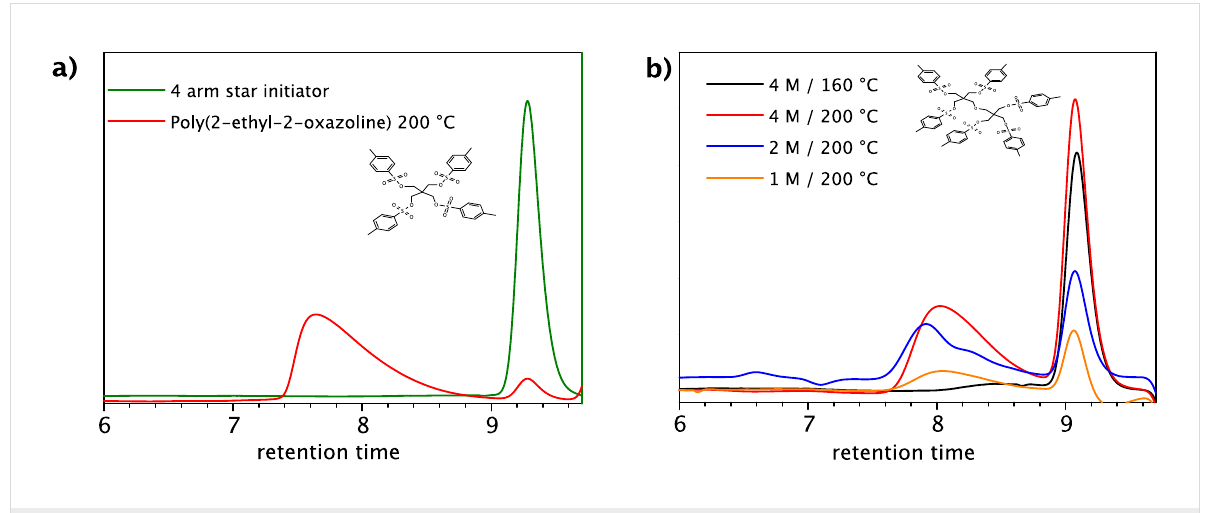
Figure 7: SEC traces obtained for the polymerization of 2-ethyl-2-oxazoline initiated with TetraTos a) and HexaTos b). The large signals at 9 to 9.5 min retention time correspond to the multi-tosylate initiators.